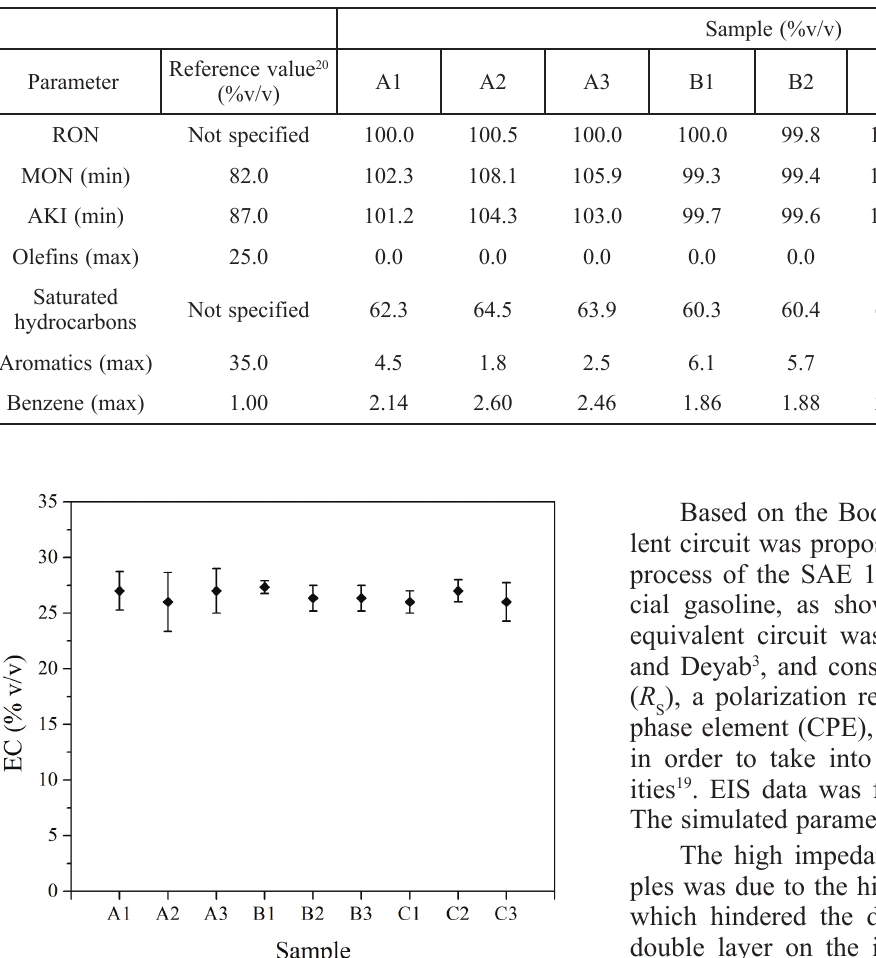
Table 1 – Composition of gasoline from different automotive fuel retail brands